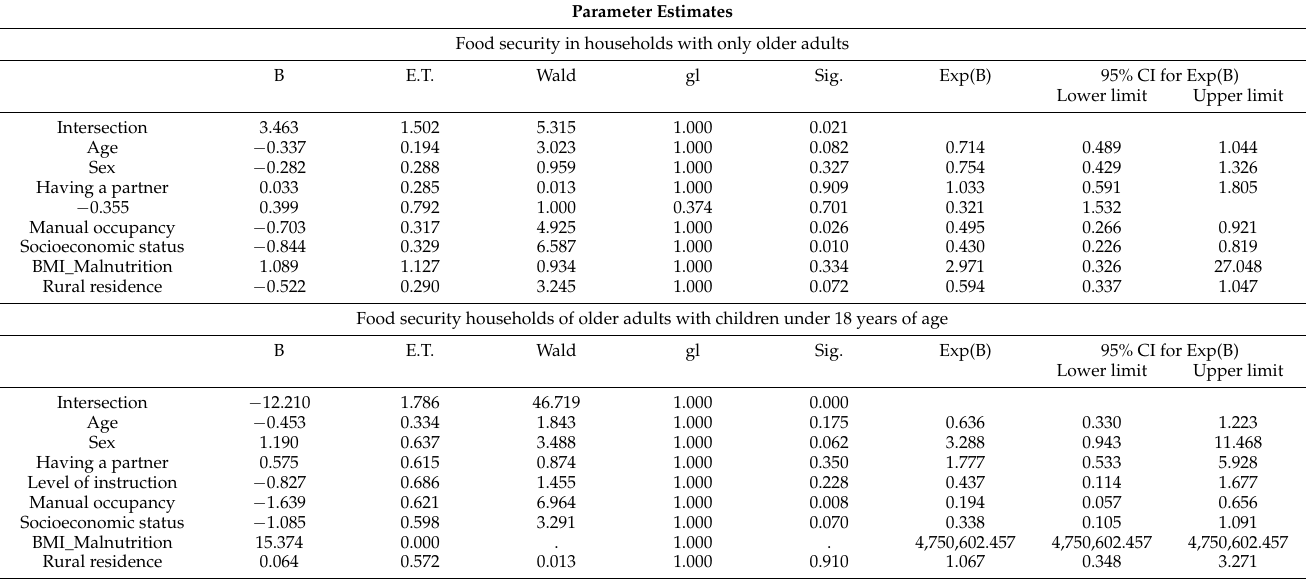
Table 6. Multivariate logistic